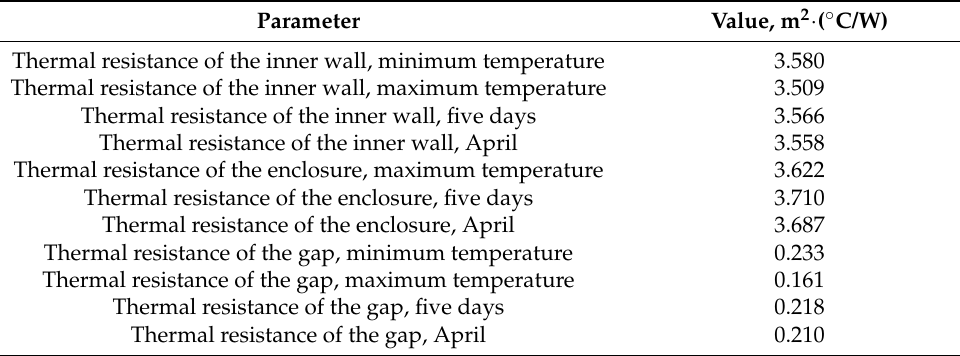
Table 6. Thermal resistance of the enclosure according to Figure 2.